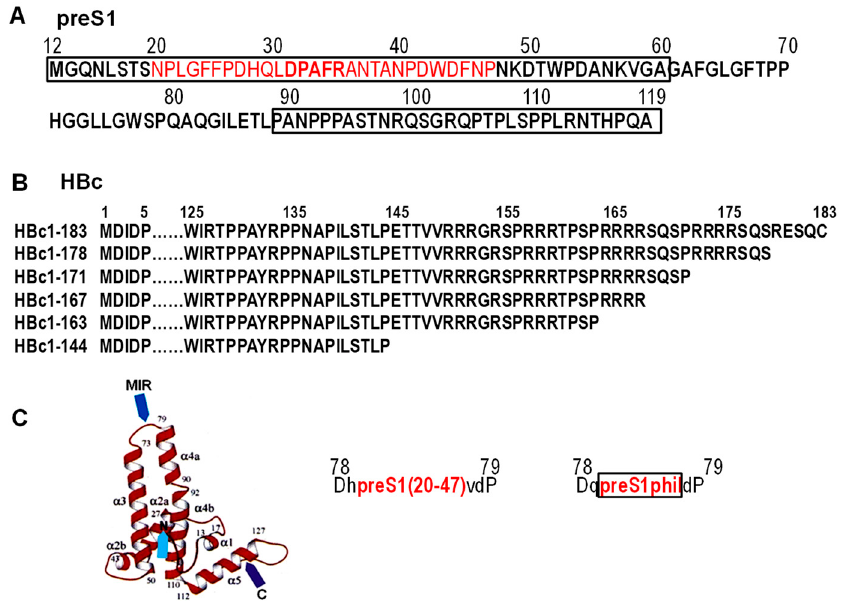
Figure 2. Structural elements used to design HBc-preS1 VLPs. ( A ) Structure of the preS1 region of HBV genotype D, and numeration of preS1 aa is according to the preS1 of HBV genotype A (GenBank accession number X70185); note: preS1 of genotype D is shorter by 11 aa than pres1 of genotype A. Short insertion fragment 20–47 is shown in red, and hydrophilic parts of the preS1 sequence spliced to create the long preS1phil fragment are shown in two boxes. Epitope DPAFR recognized by mAb MA18/7 is highlighted in bold red. ( B ) Full-length and truncated HBc vector variants were used for the insertion of preS1 fragments. Not shown aa of HBc are dotted. ( C ) Localization of surface-exposed MIR of HBc and aa surrounding the preS1 insertions: capital letters show aa of the HBc vector and small letters—linker aa added at the construction of expression plasmids. The numeration of aa in ( B , C ) is according to HBV genotype D (GenBank accession number XO2496).